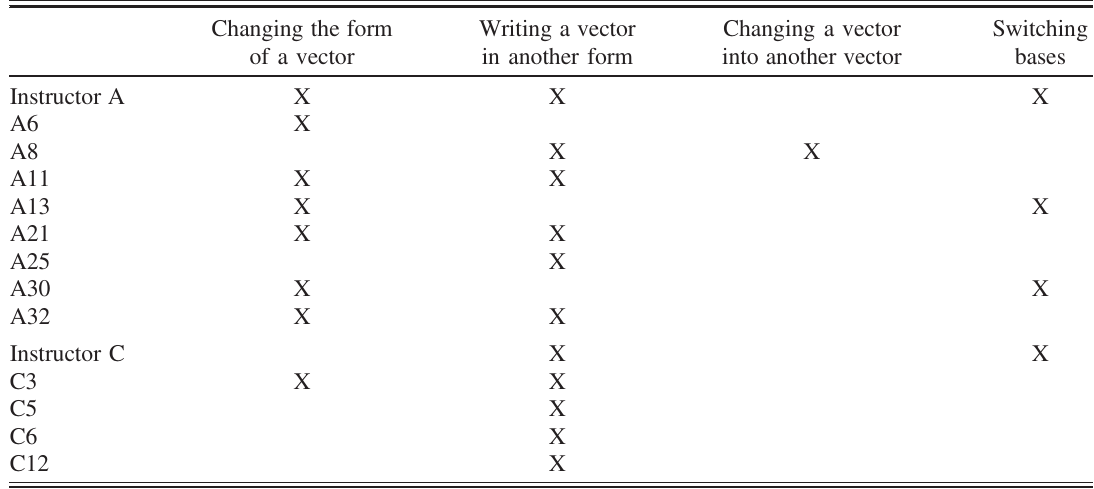
TABLE II. Each participant ’ s overall use of discourse categorized with the change of basis categories. Changing the form of a